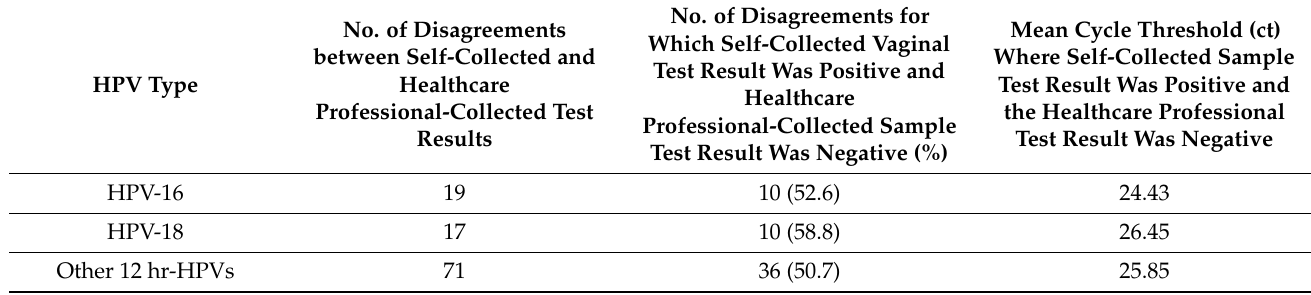
Table 3. Comparison of Abbott m2000 hr-HPV test results using paired self- and healthcare professional-collected samples.